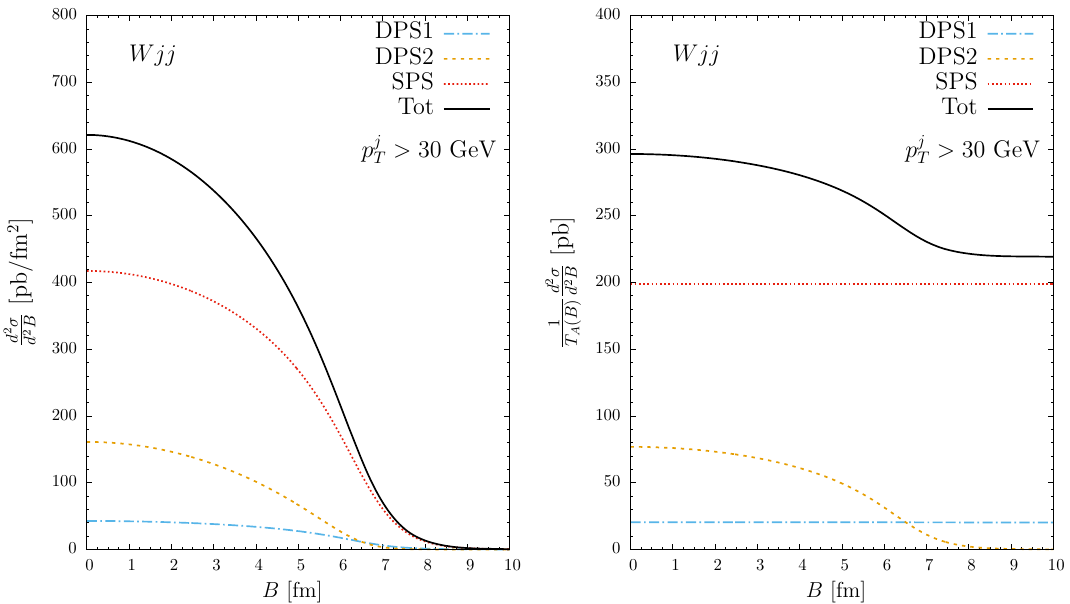
Fig. 2 W jj DPS cross section as a function of impact parameter B (left panel) and normalized to the nuclear thickness function T A ( B ) (right panel)